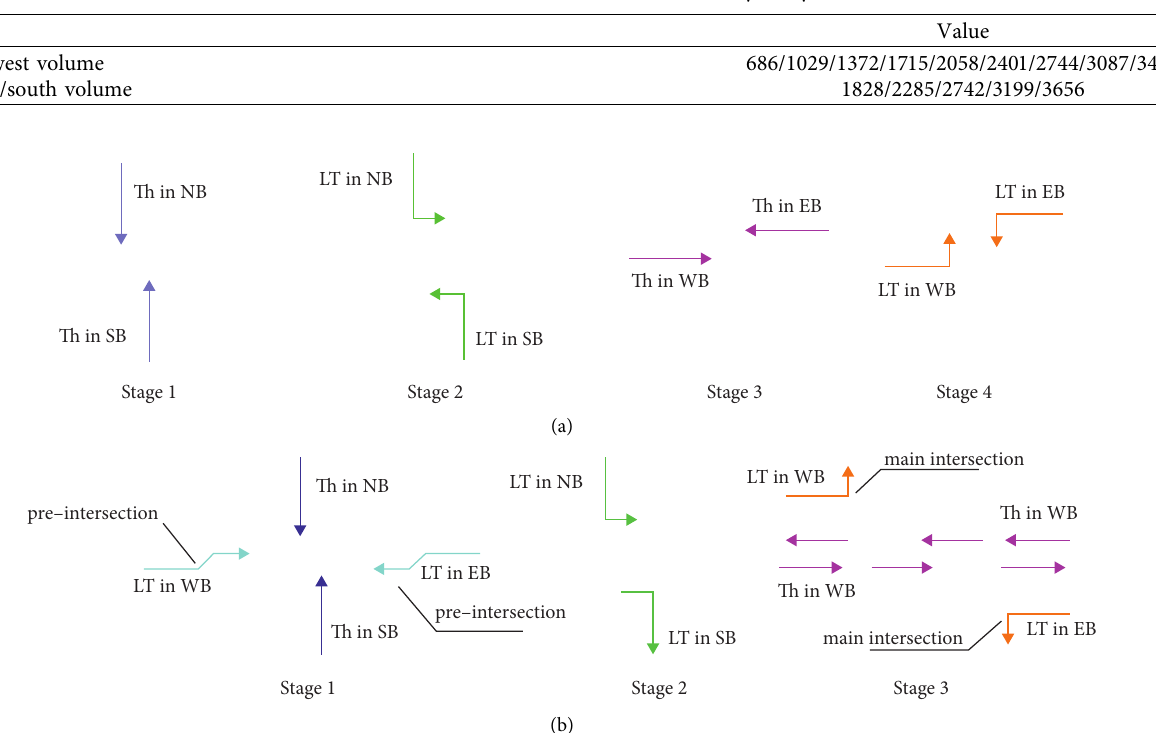
Table 7: The traffic volume combinations of the sensitivity analysis